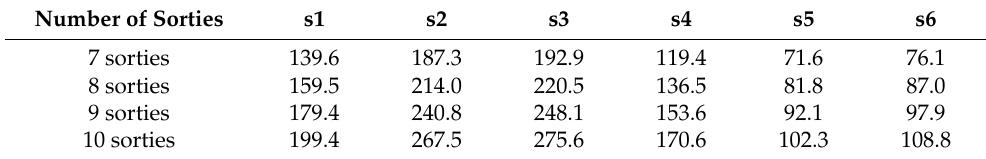
Table 10. Cost savings for EAs in all